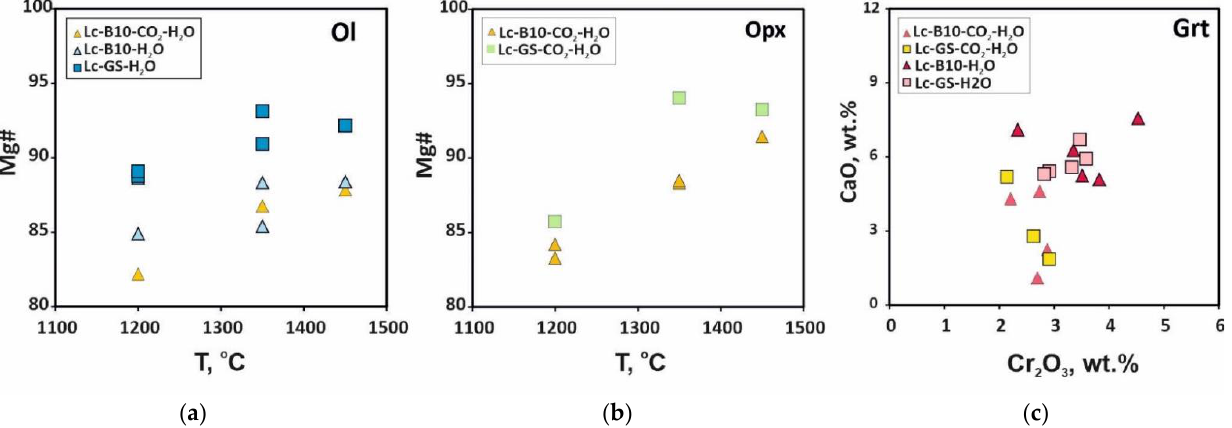
Figure 6. Compositions of olivine ( a ), orthopyroxene ( b ), and garnet ( c ) from samples produced by the interaction of lherzolite with volatile-rich carbonatitic melts. the interaction of lherzolite with volatile-rich carbonatitic